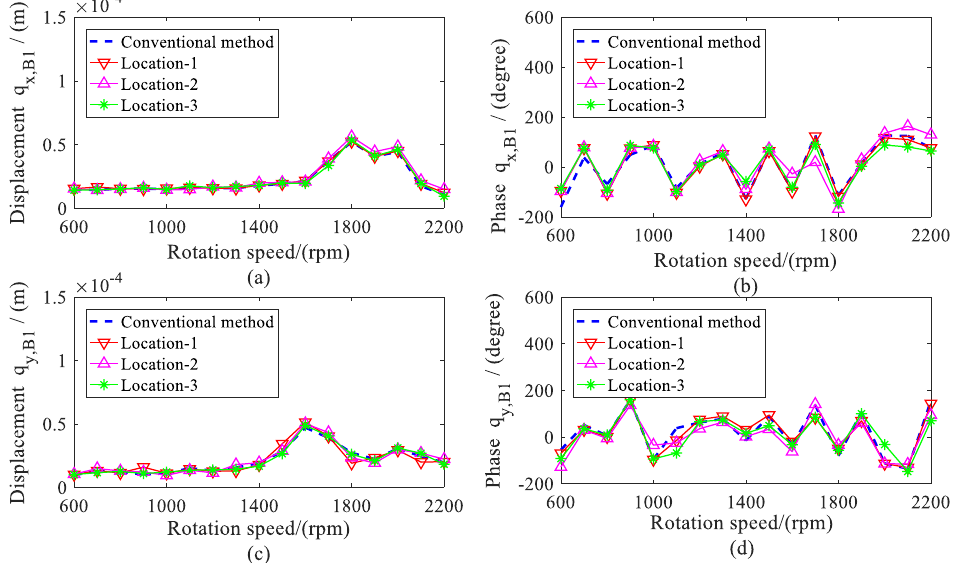
Figure 10. Comparison for displacements of bearing 1. ( a ) amplitude of q x, B 1 ; ( b ) phase of q x,B 1 ; ( c ) amplitude of q y, B 1 ; ( d ) phase of q y, B 1 .